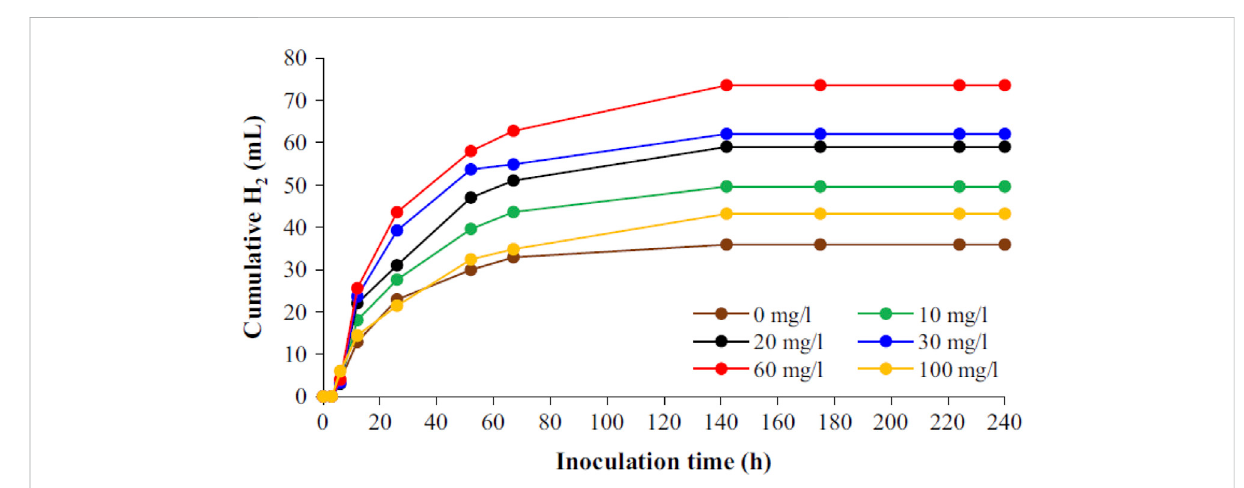
FIGURE 12 Cumulative hydrogen production at different concentrations of Ni-Gr NC (Elreedy et al.,